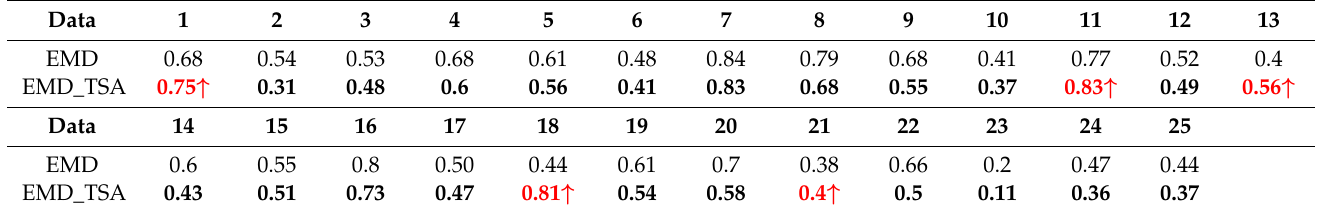
Bold font indicates the false-alarm rate of EMD_TSA is lower than that of EMD model. Red font indicates that the false-alarm rate of the EMD_TSA is higher than that of EMD model. Red arrows indicate the increase of false-alarm rate.